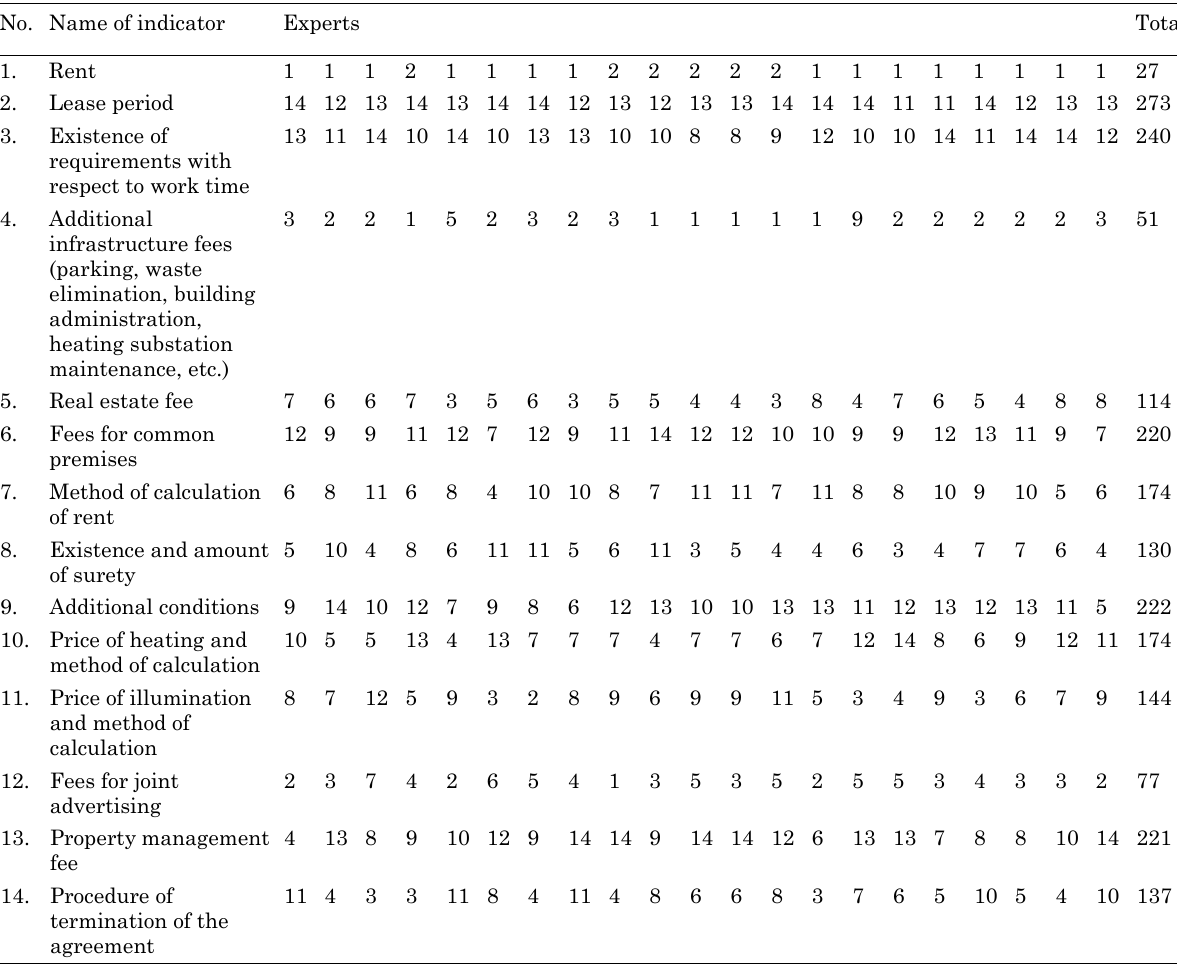
table 2. results of the ranking of importance of the economic lease indicators